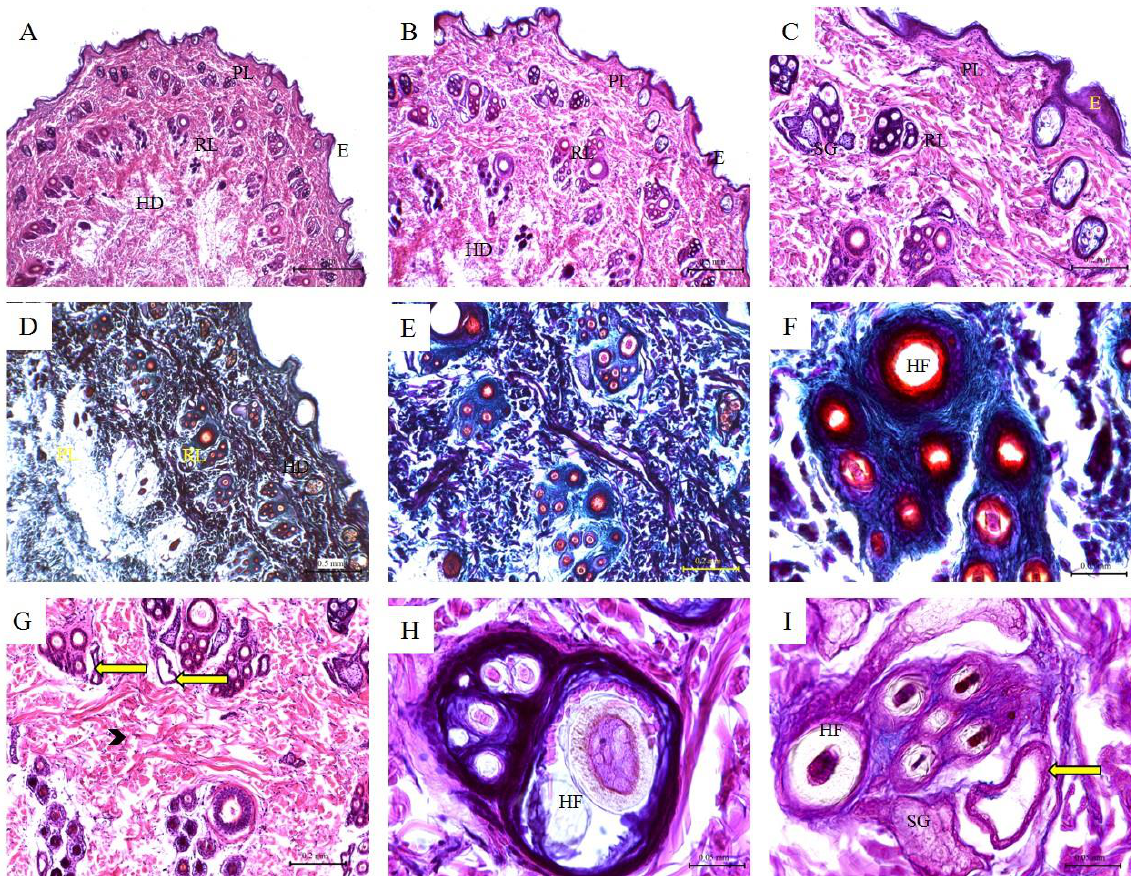
Figure 6: Histological features of dog skin. Hematoxylin and eosin staining ( A-C ; G-H) ; Crossman's trichrome staining ( D-F) ; and PAS staining ( I ) of dog skin tissue sections. E) Keratinized stratified squamous epithelium of the epidermis; (PL) Papillary layer of the dermis; (RL) Reticular layer of the dermis; (SG) Sebaceous glands; (Arrow heads) collagen bundles of the reticular layer; (Yellow arrow) Sweat glands; (HF) Hair